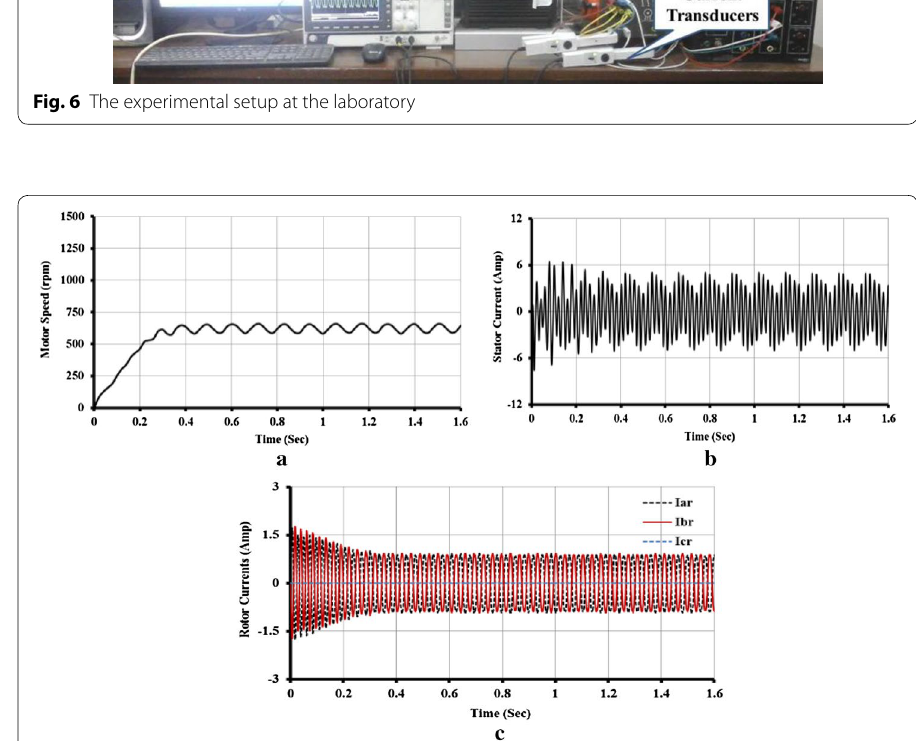
Fig. 7 Experimental results for isolated neutral star connection, a motor speed, b stator phase current and c rotor